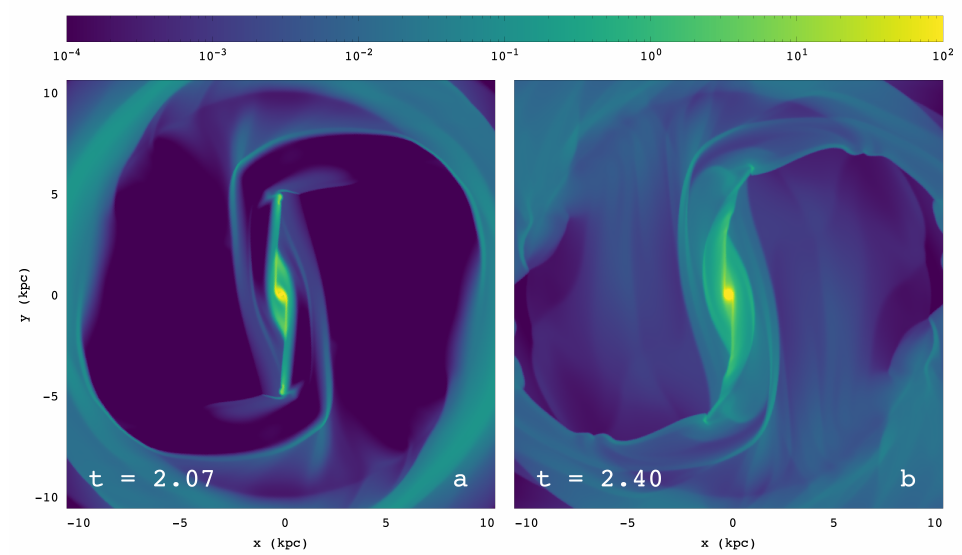
Figure 16. Typical responses in a RAMSES model with c s = 10 km s − 1 ( a ) and c s = 20 km s − 1 ( b ). The rest of the initial conditions are as in the model of Figure 13. In ( a ), the response does not differ essentially from the model with c s = 5 km s − 1 , while in ( b ) we observe instabilities in the shocks in regions with high density